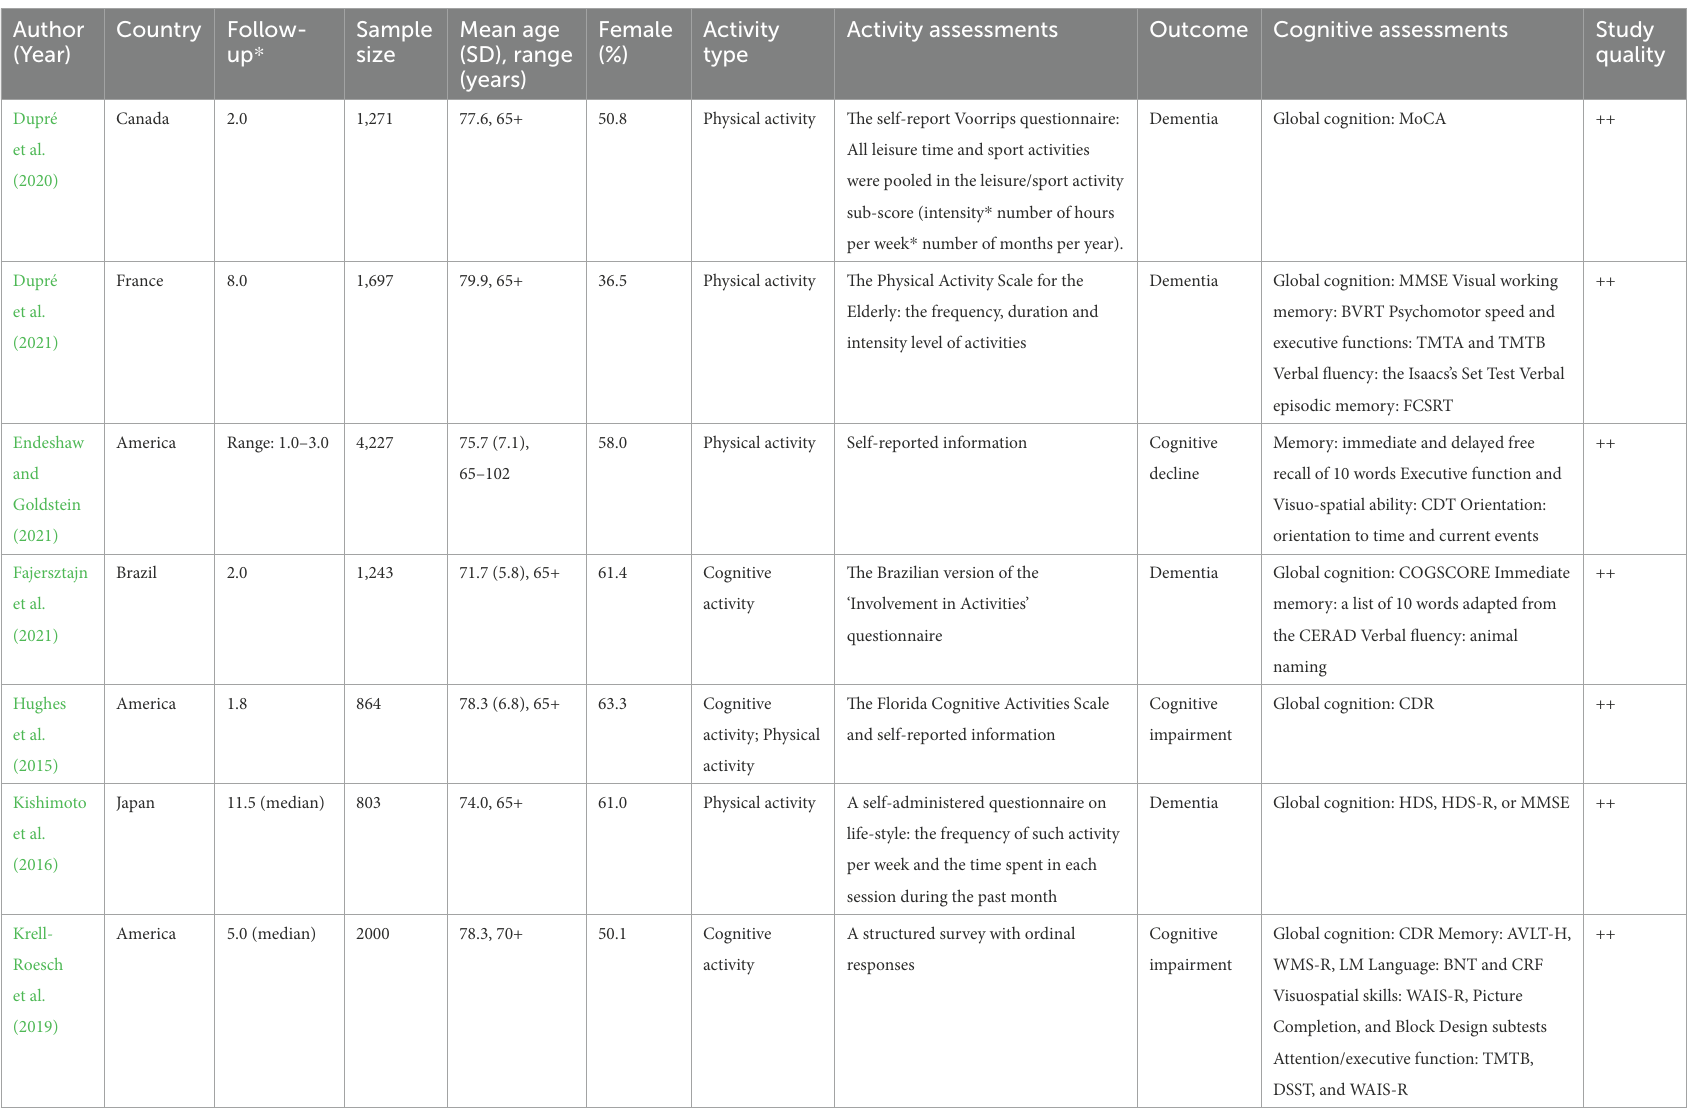
TABLE 1 Characteristics of the included